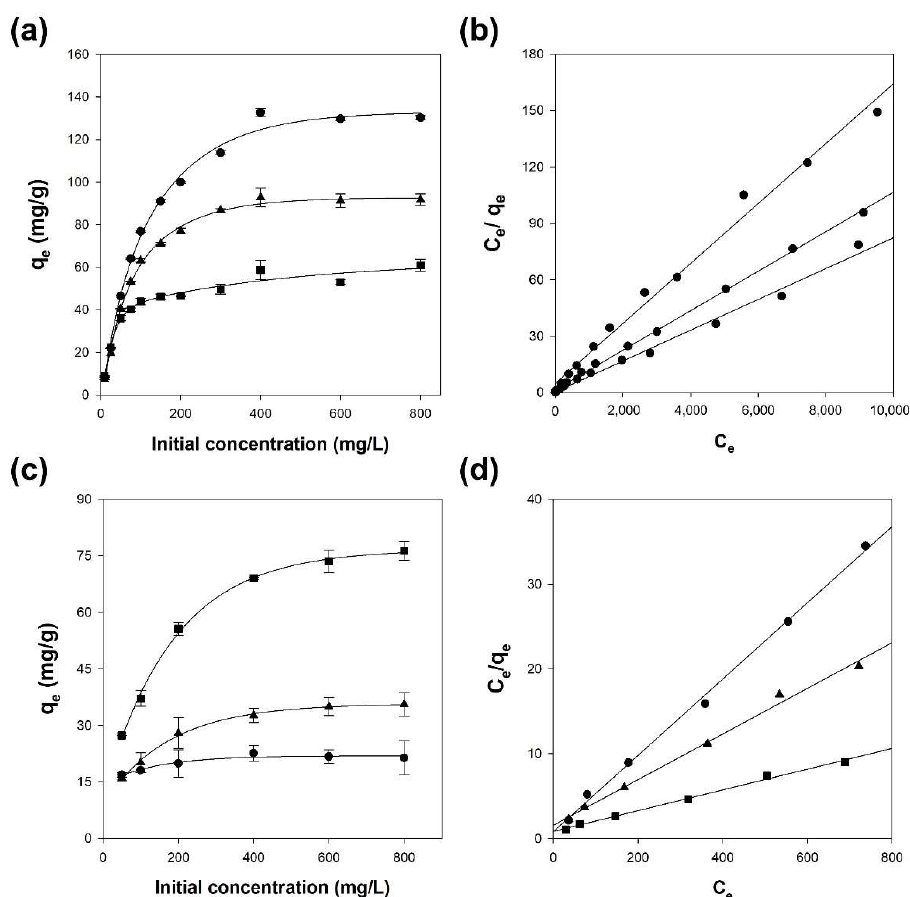
Figure 6. Isotherm studies of Cu 2+ ( a , b ) and benzene ( c , d ) adsorption onto alginate and alginate/bi- ochar hydrogel beads (●: 4% alginate/0% biochar; ▲ : 4% alginate/1% biochar; ■ : 4% alginate/4% biochar). Effect of initial Cu 2+ ( a ) and benzene ( c ) concentrations and Langmuir as the best-fitted isotherm model of Cu 2+ ( b ) and benzene ( d ).